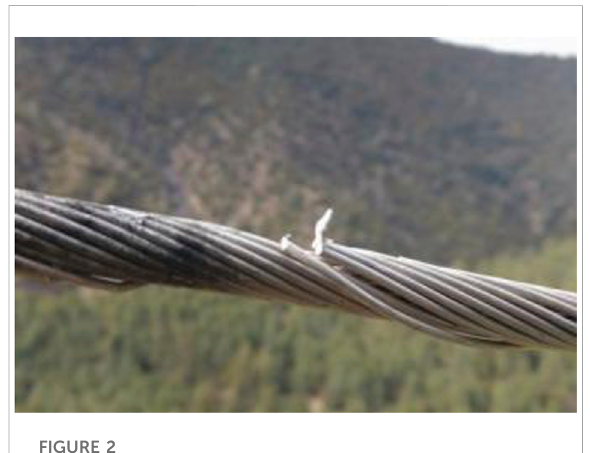
FIGURE 2 The transmission lines were broken by a lightning strike. FIGURE 3